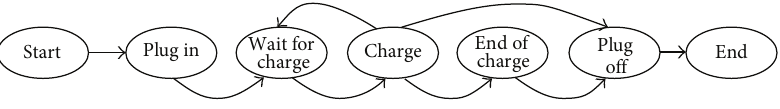
Figure 2: Managed Charging